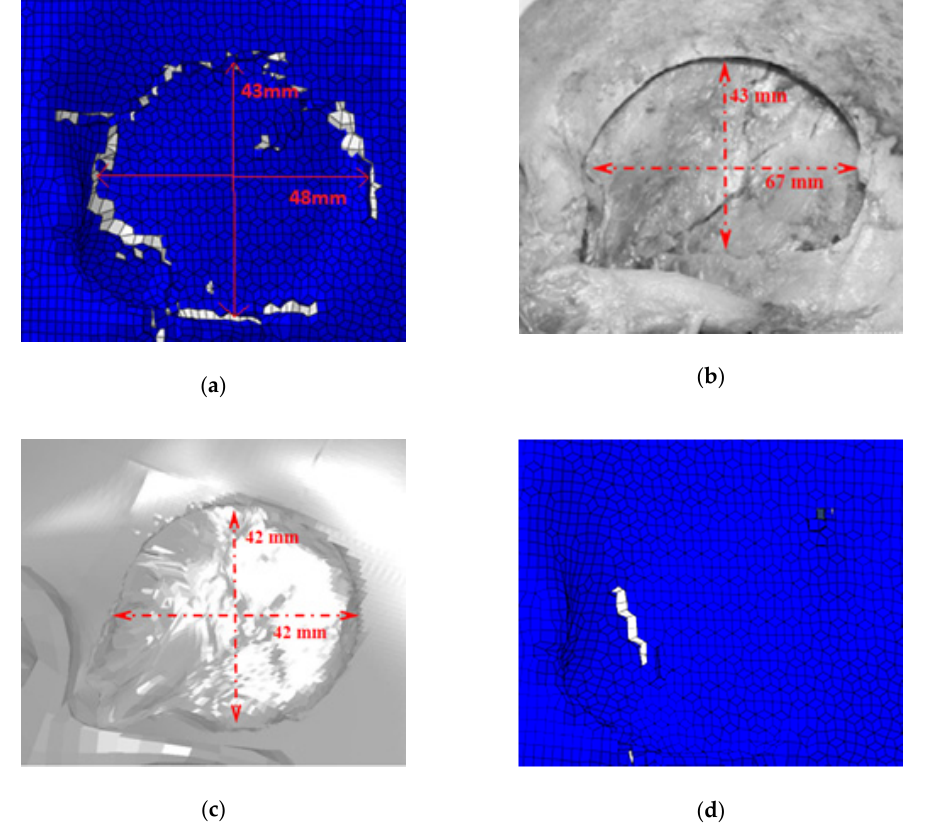
Figure 14. Comparisons of depressed skull fracture pattern obtained with YEAHM and in both Huang’s experiment and simulation: ( a ) fracture pattern from the 35 m/s simulation; ( b ) fracture pattern from the 35 m/s experiment (adapted from [37]); ( c ) fracture pattern from the 35 m/s simulation with the model from Huang et al. [37] (adapted from [37]); ( d ) fracture pattern from the 20 m/s simulation.